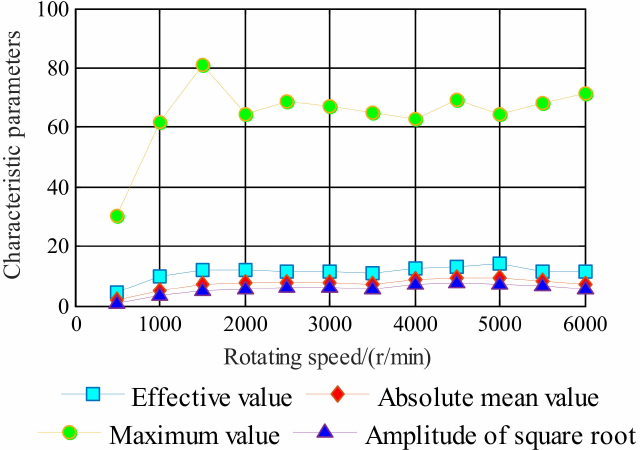
Figure 26. Influence of working speed on dimensional